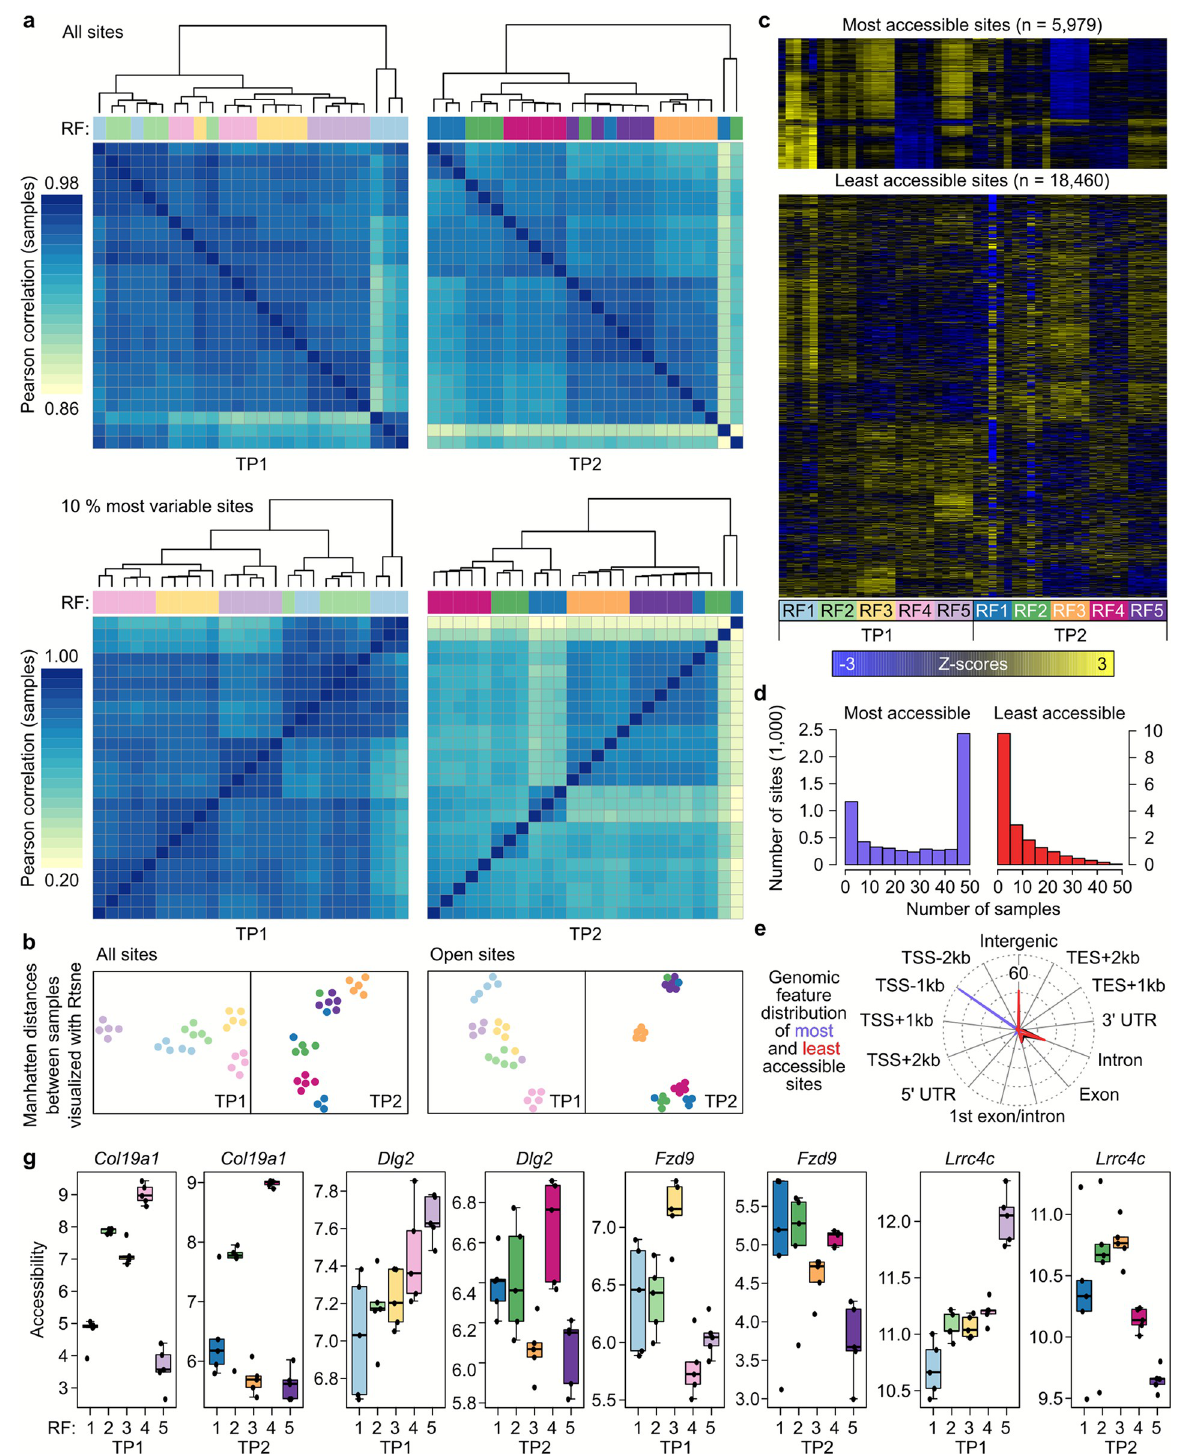
Fig 3. Differences in neuronal chromatin accessibility between males from different RFs. (a) Sample correlation matrices based on all sites and the 10% most variable ATAC-seq sites ( n = 5 mice/RF/TP). ( b) Manhatten distances between samples for all sites and open chromatin sites visualised by t-SNE. ( c) ATAC-seq accessibility signal in response to the different RFs and TPs. Heatmap representation of the most and least accessible sites. The color represents the intensity of chromatin accessibility, from gain (yellow) to loss (dark blue), calculated by using row wise Z-scores (the values are scaled by subtracting the average across samples and by dividing by the standard deviation across samples). ( d)